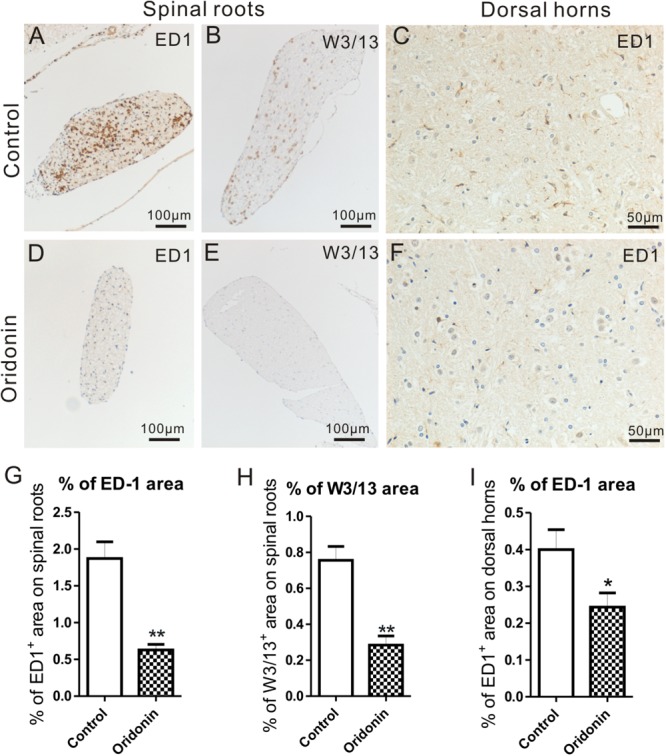
Oridonin treatments attenuated cellular infiltration in spinal roots and inflammatory microglial activation in lumbar spinal cords of EAN rats. EAN Rats were preventively treated with Oridonin and sacrificed on Day 15, spinal cords were taken for immunohistochemical staining and analyzed, especially focusing on lumbar sections. Significant accumulation of ED1+ and W3/13+ cells was mainly observed in dorsal roots of our EAN rats (A,B). Similar to sciatic nerves, they were mainly detected to concentrate around vessels in perineurium and endoneurium. Following the Oridonin treatment, their accumulations were significantly reduced (D,E,G,H). The expression of ED1 in lumbar spinal cords was further analyzed. In lumbar spinal cords of EAN rats, significantly increased ED1 expression could be observed in the control group (C). ED1 IR was mainly detected in gray matter, particularly in the superficial layers of dorsal horns. The density of ED1 IR in dorsal horns was then investigated, and it was significantly decreased by Oridonin treatment (F), compared to the control group (I). ∗p < 0.05, ∗∗p < 0.01 compared to the control group, n = 6.